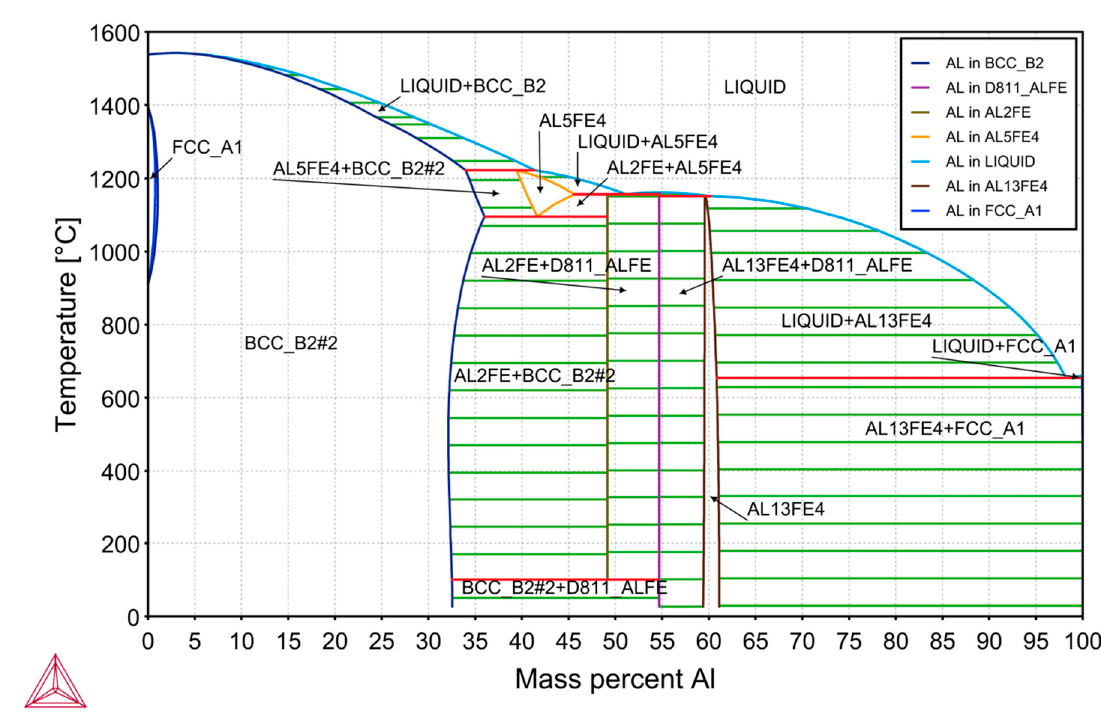
Figure 1. Calculated equilibrium system of Al–Fe alloys obtained in the Thermo-Calc program. The Thermo-Calc program was also used to develop the Fe-Al-C triple system. This diagram was produced for a temperature of 1400 °C and is shown in Figure 2a. It is worth noting that, at this temperature, it is possible for graphite formation to start from the carbon content of 2.5% in the alloy. Figure 2b shows the course of the liquidus line in the Fe-Al-C alloy.